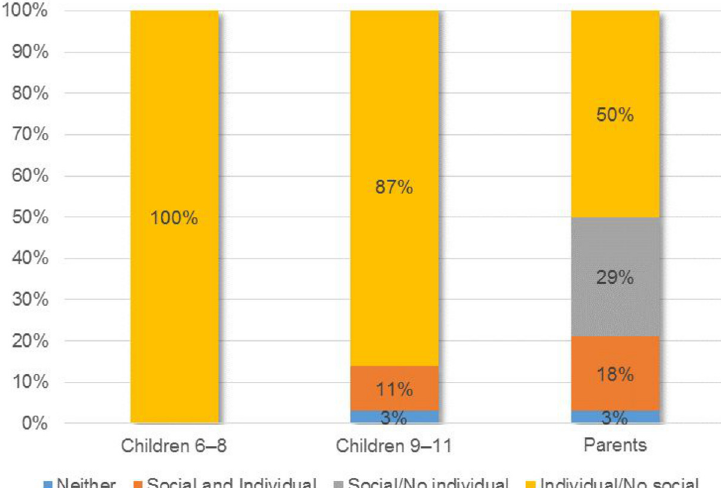
Fig 3. Frequencies of the composite models created on the open-ended responses.